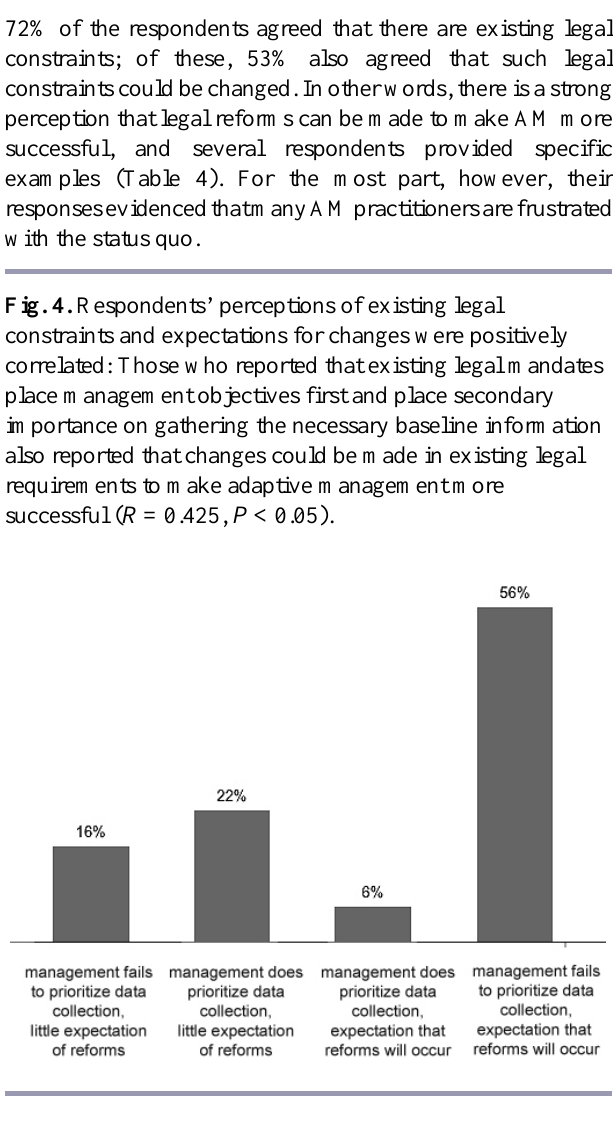
Fig. 3. Respondents’ perceptions of existing legal barriers as